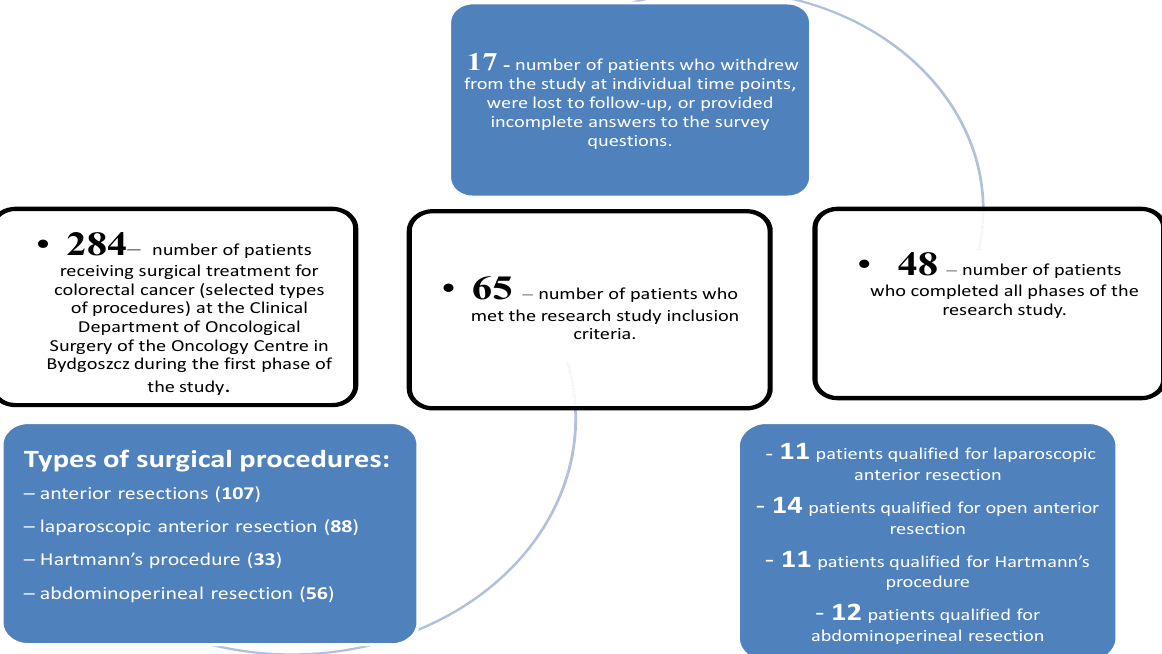
Figure 1. Scheme describing the exclusion of patients from the study.